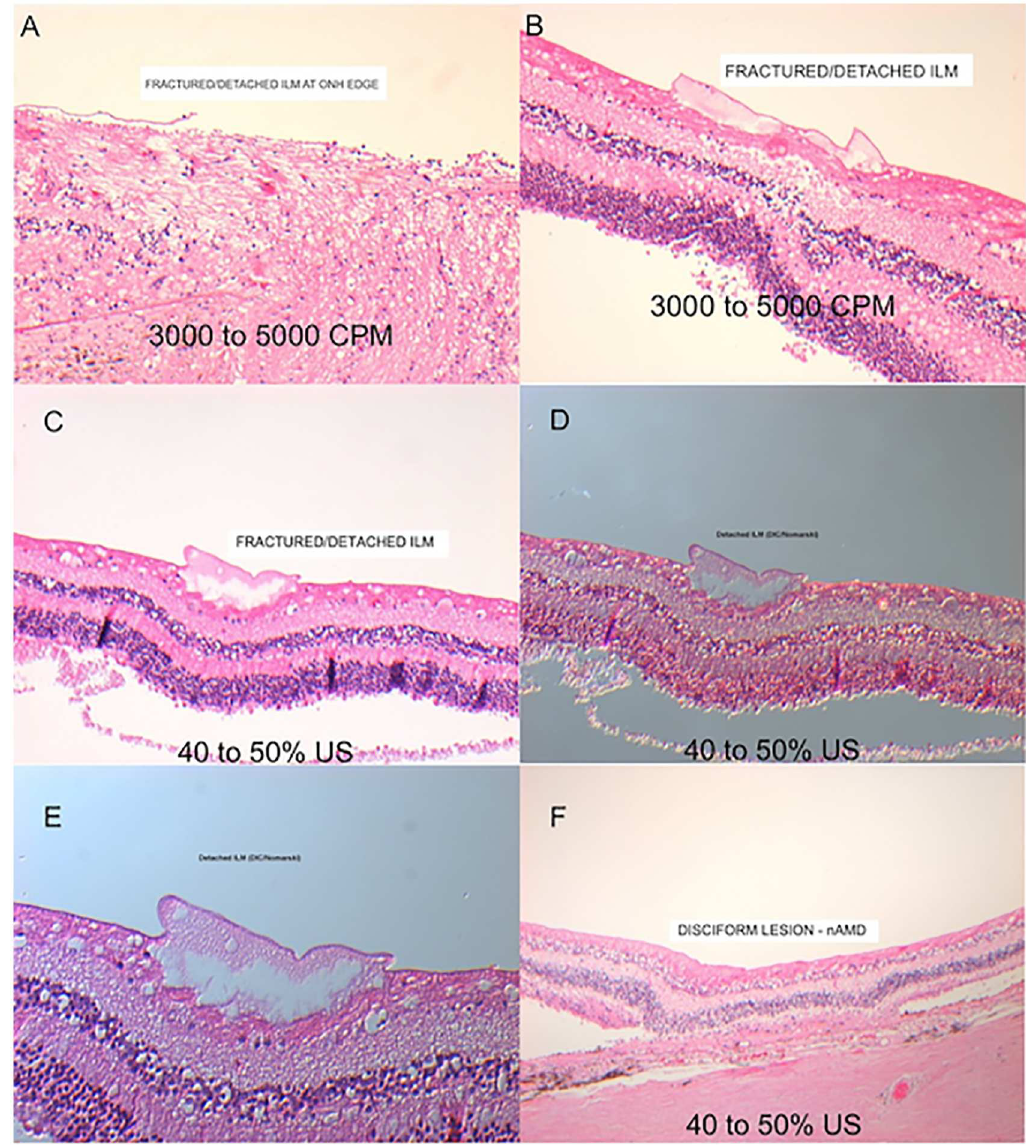
Fig 6. Hematoxylin-eosin stained histological sections of human retina after pars plana vitrectomy. All sections (A-C and F) show fragmentation and separationof the inner limitingmembrane. (A and B) vitrectomy with a guillotine vitrector at 3000–5000cuts per minute. (C) vitrectomy with a hypersonic vitrector at 40%–50% ultrasoundpower. (D-E) Differential interferencecontrast microscopy to enhancethe contrast of ILM. (E) magnifiedimage showingILM fragmentation. (F) vitrectomy with a hypersonicvitrector at 40%–50% ultrasoundpower. Disciform macular degeneration.